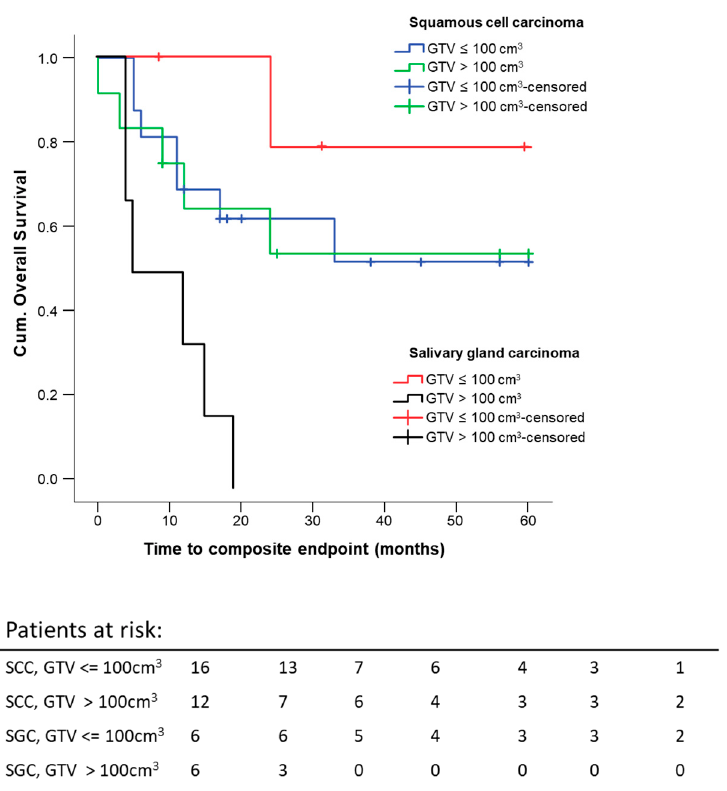
Figure 8. Five-year composite overall survival depending on the GTV and histology: All patients were stratified according to histology and GTV. Kaplan–Meier curves for each analyzed group were calculated from the date of diagnosis.